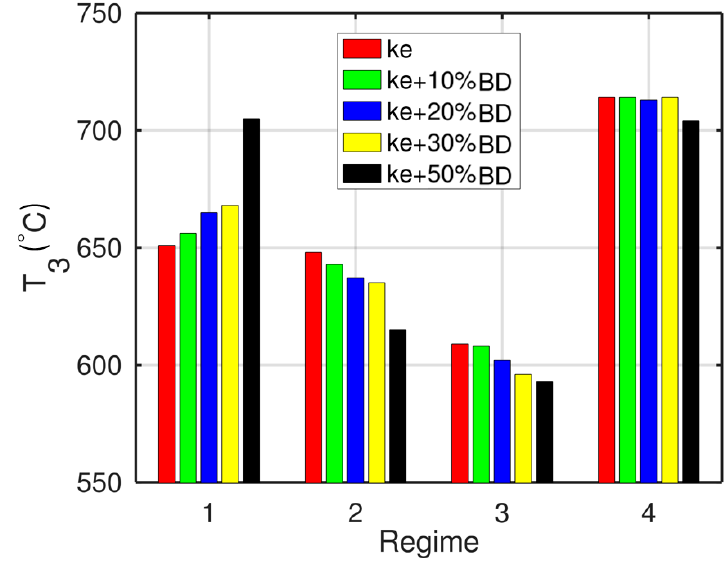
Figure 9. Variation of T 3 (°C) depending on regime and blends.